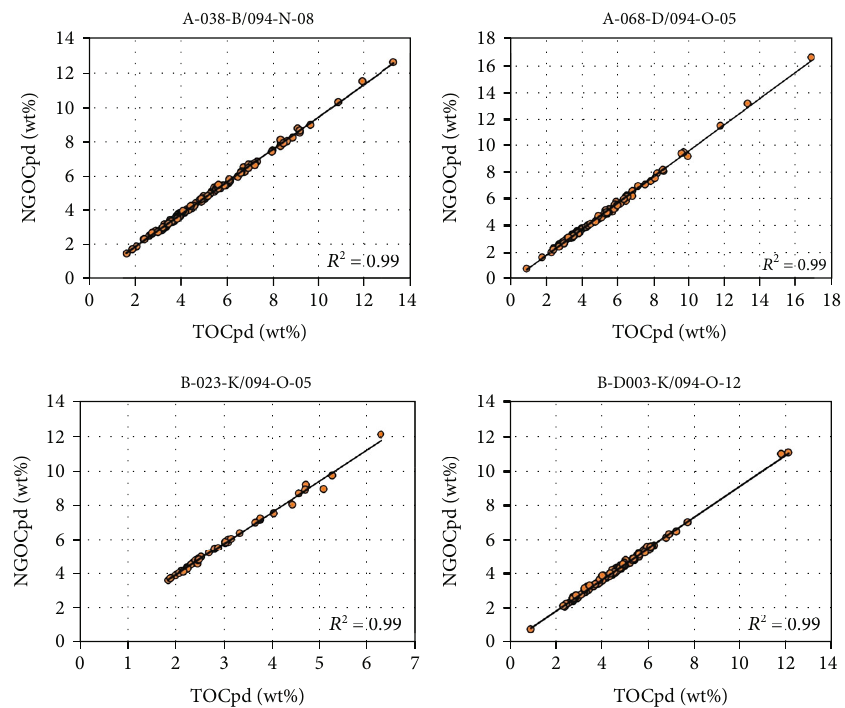
Figure 7: Correlation between calculated NGOCpd and TOCpd of A-038-B/094-N-08 [17] and A-068-D/094-O-05 [18], and B-023-K/094- O-05 [19] and B-D003-K/094-O-12 [19]. These boreholes have considerably high coe ffi cient of determinations. The NGOCpd can be alternative to TOCpd in Equation